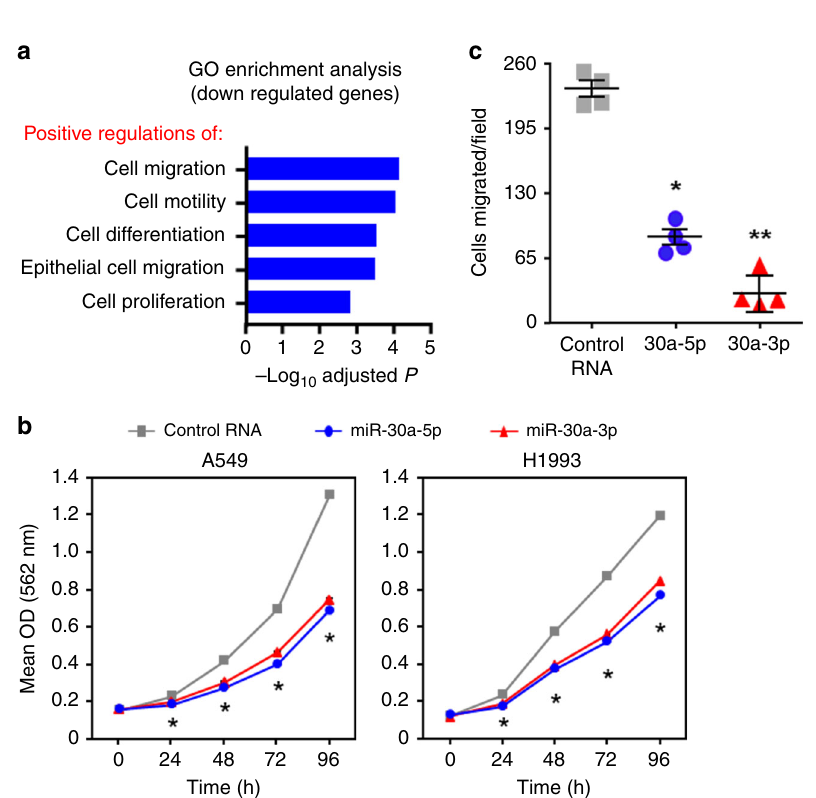
Fig. 4 Increased levels of miR-30a-5p and miR-30a-3p decreased lung cancer cell growth and migration. a Gene Ontology enrichment analysis based on genes that were signi fi cantly downregulated by either miR-30a-5p or miR-30a-3p determined from our RNA-seq data (GSE142695). Biological processes that were signi fi cantly enriched with downregulated genes are indicated. b Lung adenocarcinoma lines were transfected with 100 nM miR-30a-5p mimic, miR-30a-3p mimic, or a negative control RNA. MTT assays were performed at the indicated intervals in quadruplicate. Each assay was performed at least four independent times for both cell lines; a representative experiment is shown. For A549, * P < 2.43 × 10 − 3 ; for H1993, * P < 2.91 × 10 − 6 ; two-tailed t -tests (comparing 5p or 3p mimic to control RNA); error bars are within the symbols. c A549 cells transfected with miR-30a-5p mimic, miR-30a-3p mimic, or control RNA and transwell migration assays performed. Results from one representative experiment from two independent experiments performed is shown; * P = 1.11 × 10 − 5 , ** P = 3.15 × 10 − 6 , two-tailed t -tests (comparing 5p or 3p mimic to control RNA, respectively). Data are presented as mean values ± SEM in b and c . Source data are provided as a Source Data fi